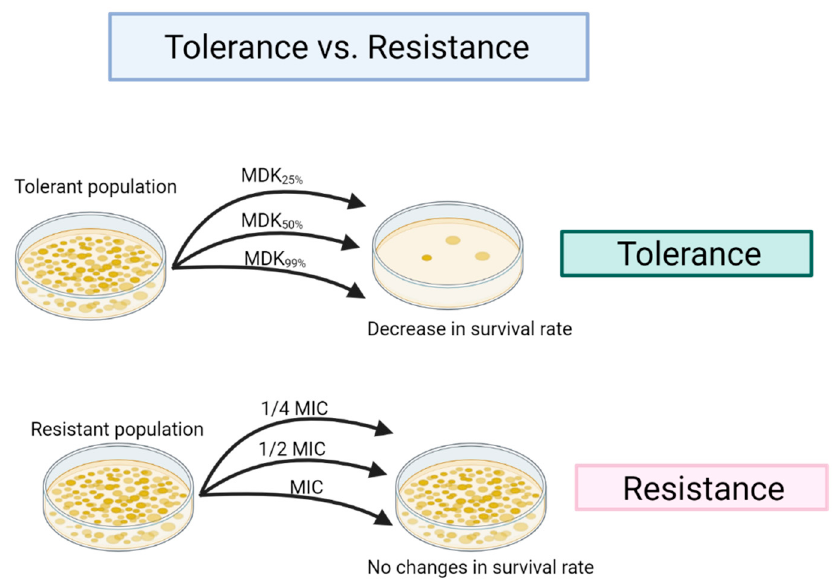
Figure 6. The differences between resistance and tolerance. Resistance refers to an inherited decrease in antimicrobial effectiveness and is usually determined using minimum inhibitory concentration (MIC) testing, while tolerance, which is also associated with treatment failure, cannot be measured with such testing because tolerant specimens could have the same MIC values as susceptible strains.